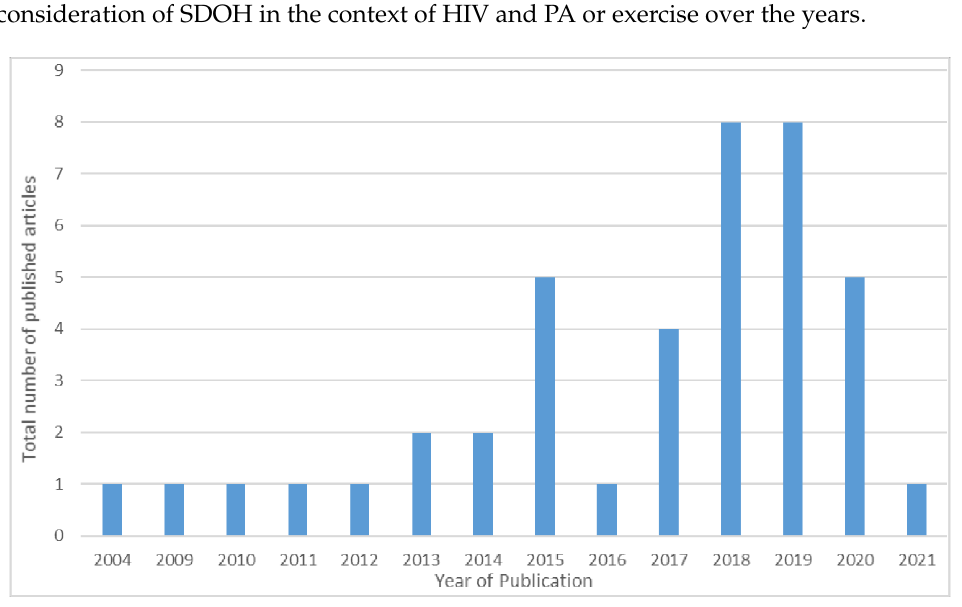
Figure 2. Timing of publications of the 41 included articles between the year 2004 and 2021.